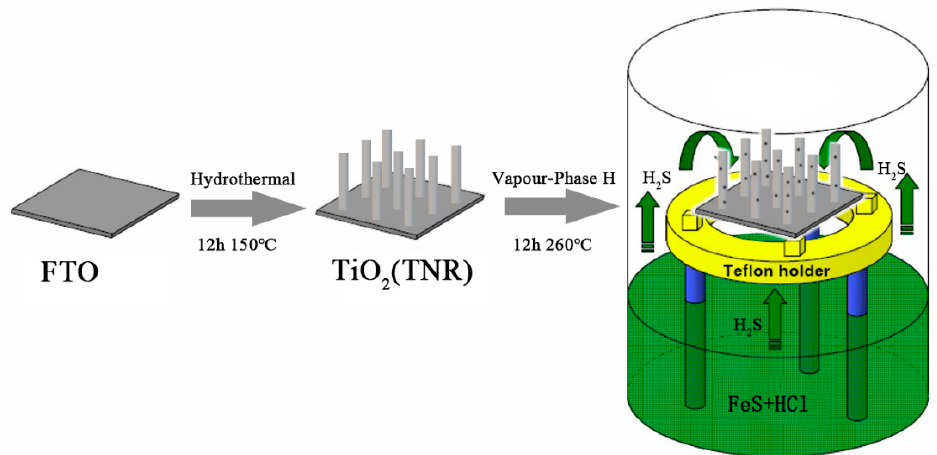
Scheme 1. Fabrication procedure of S 2 − -TiO 2 by the vapor-phase hydrothermal (VPH)